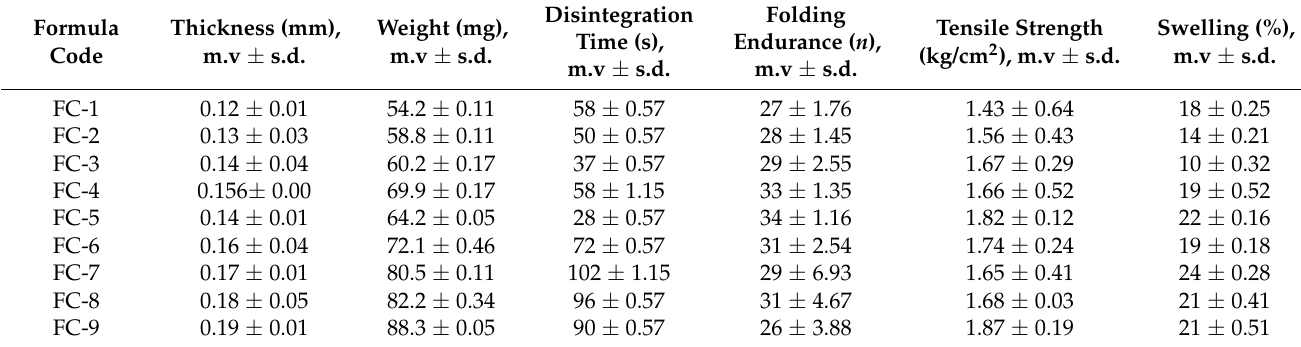
Table 3. Physical properties of developed orodispersible sublingual